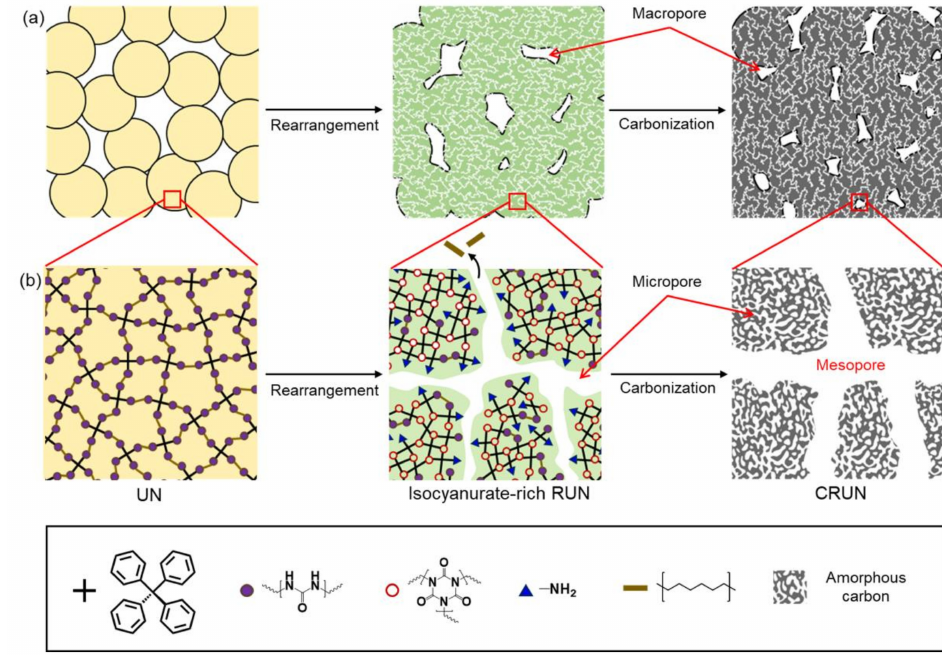
Figure 5. Schematic illustration of pore formation and structural change in the transformation from UN to RUN to CRUN. ( a ) Macropore formation in UN, RUN, and CRUN. ( b ) The formation of the mesopore and micropore with the change in network structure in the UN, RUN, and CRUN.